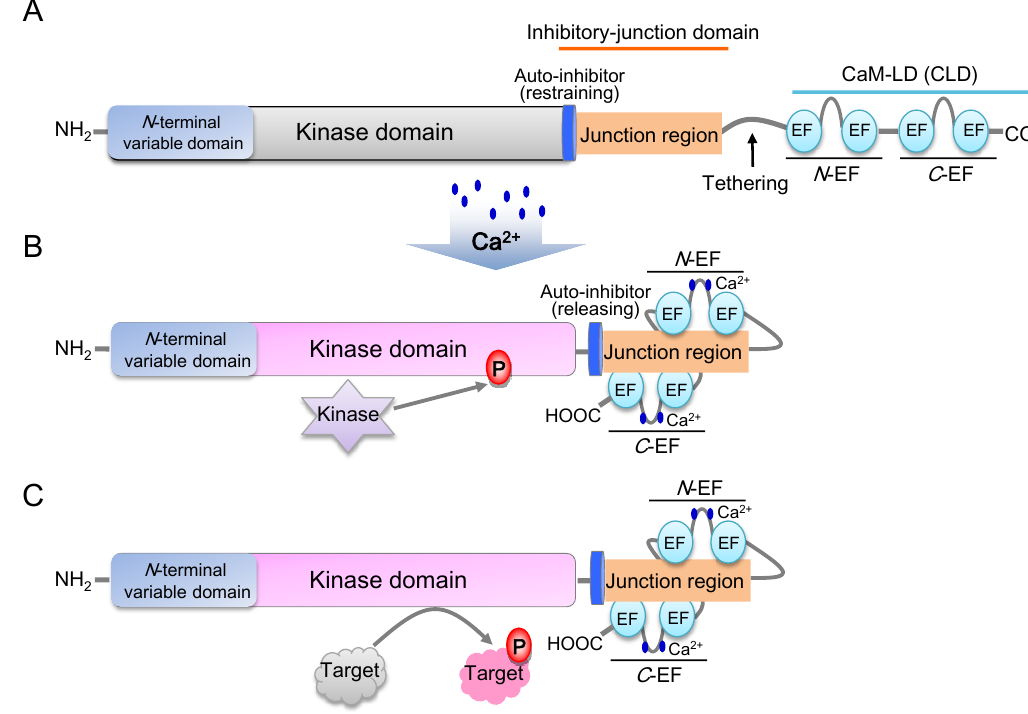
Figure 2. Diagram of CDPK structure and the Ca 2+ -CDPK decoding Mechanism (modified from [68]). ( A ) Inactive state of the CDPK protein. The auto-inhibitor restrains the kinase activity, while EF-hand motifs do not bind to the junction region. ( B ) Active state of the CDPK protein. After Ca 2+ uploading into elongation factor (EF) hands, N -EF and C -EF hands combine with different sides of junction region, then the kinase domain is released and phosphorylated simultaneously by an upstream kinase. ( C ) Phosphorylation of target proteins.